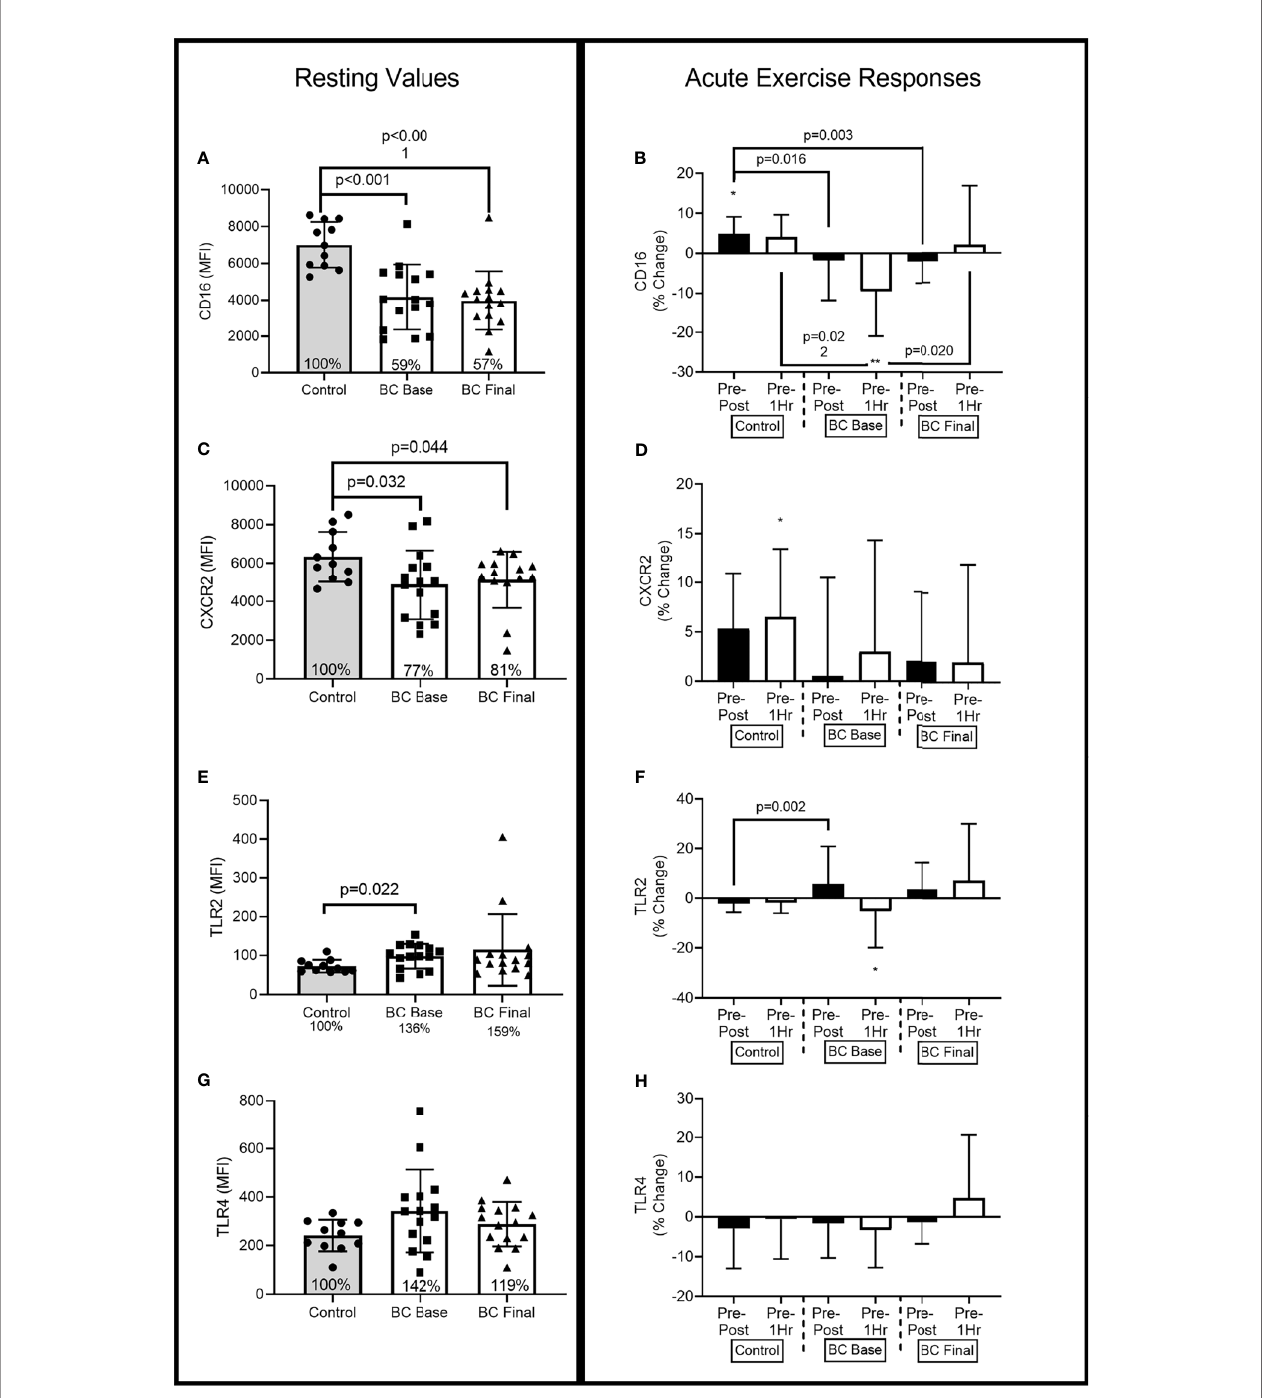
FIGURE 3 | Neutrophil surface receptor expression (MFI) differences between Controls and BCS measured once in Controls, and before and after 16 weeks of exercise in BCS. Panels show, resting values (Top Panels) and acute exercise responses (Bottom Panels) for percentage changes pre exercise to immediately post exercise (Pre-Post), and Pre exercise to 1 hour after exercise completion (Pre-1Hr). Panels show CD16 expression at rest (A) and during acute exercise (B) , CXCR2 expression at rest (C) and during acute exercise (D) , TLR2 expression at rest (E) and during acute exercise (F) , and TLR4 expression at rest (G) and during acute exercise (H) . *p < 0.05, and **p < 0.01 signi fi cant change for groups acute response. Where shown, the Controls mean values have been assigned 100% to represent the optimal response, and BCS the percentage of Control means. Data are mean